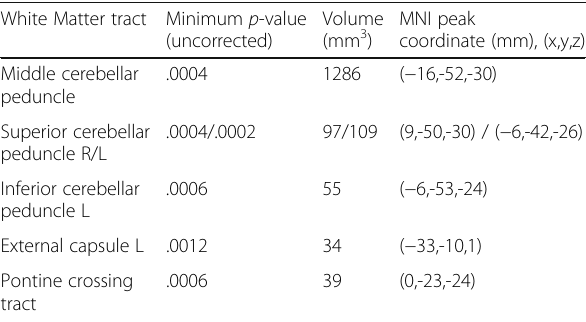
Table 4 White matter regions from the ICBM-DTI-81 White Matter Atlas for which significant decreased AD values were found in CM compared to EM considering the effect of time from onset of CM